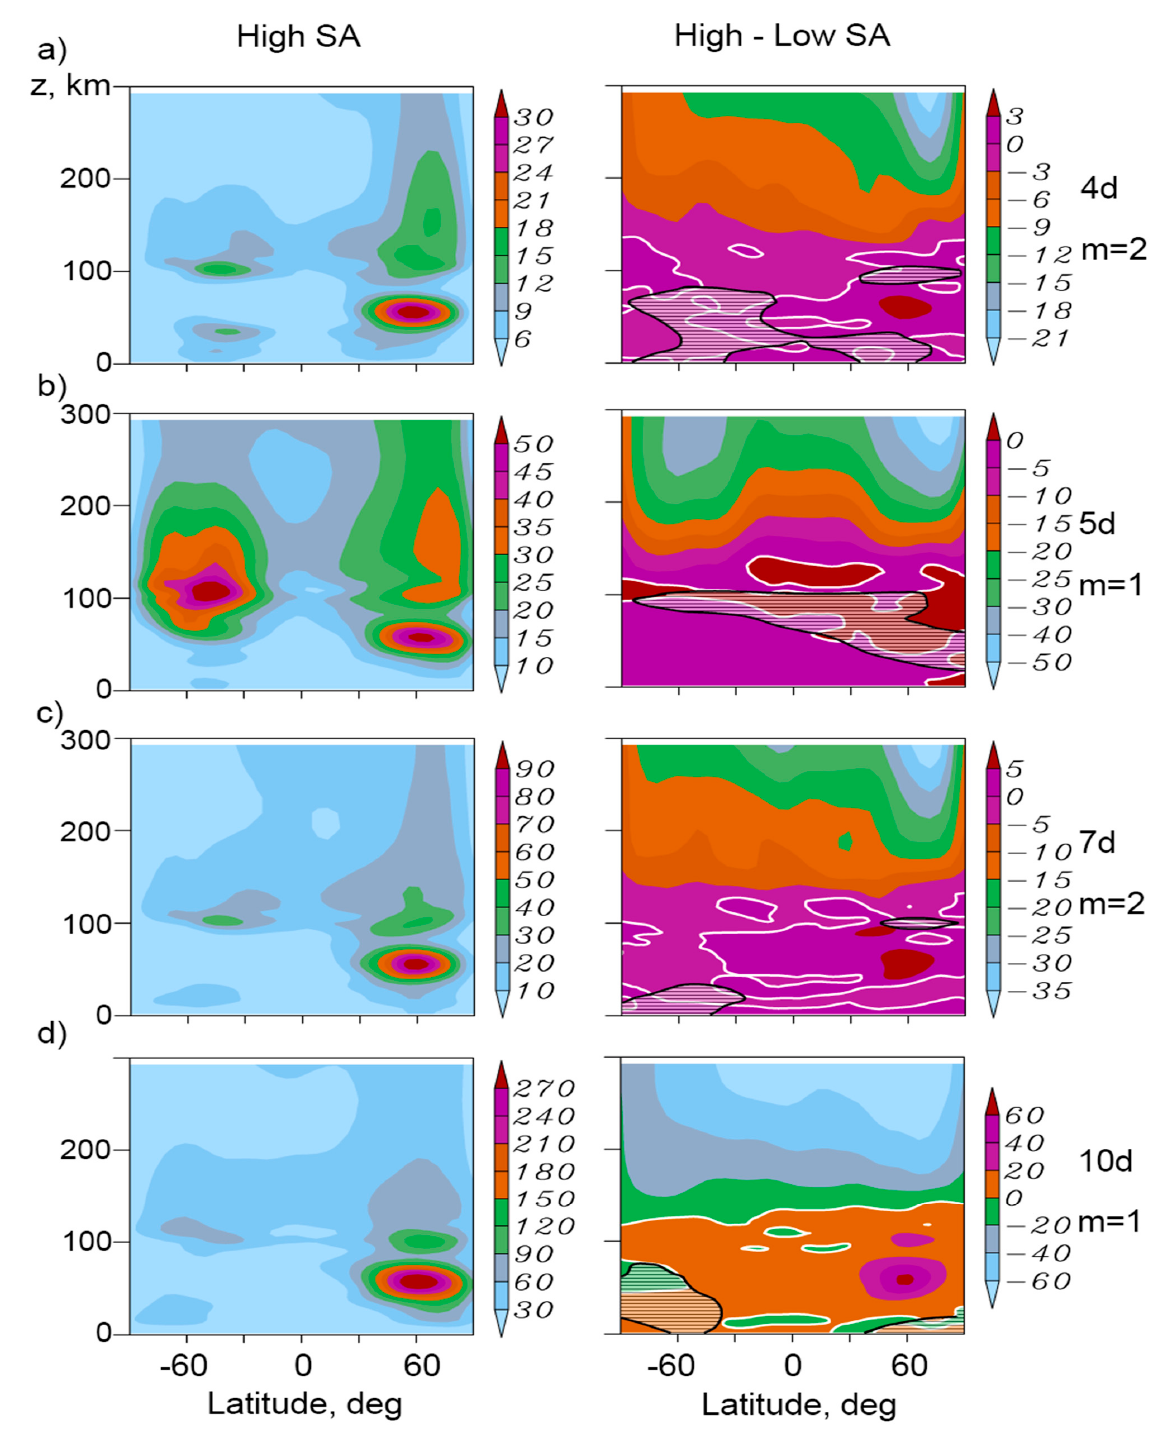
Figure 2. Amplitudes of the geopotential height variations (in gp.m.) caused by the westward − travelling PWs having periods 4, 5, 7 and 10 days (( a – d ), respectively) under high SA ( left ) and differences ( right ) due to SA changes in thermosphere, averaged over 16-member ensembles and from mid − December–February. Areas shaded with lines show statistically unconfident differences. Altitude range 0–300 km.